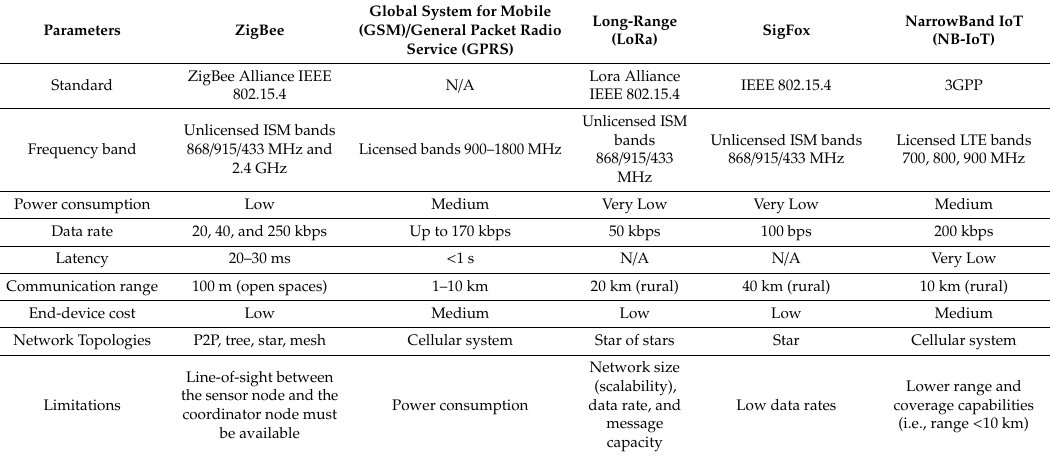
Table 1. Comparison between the di ff erent communication technologies for